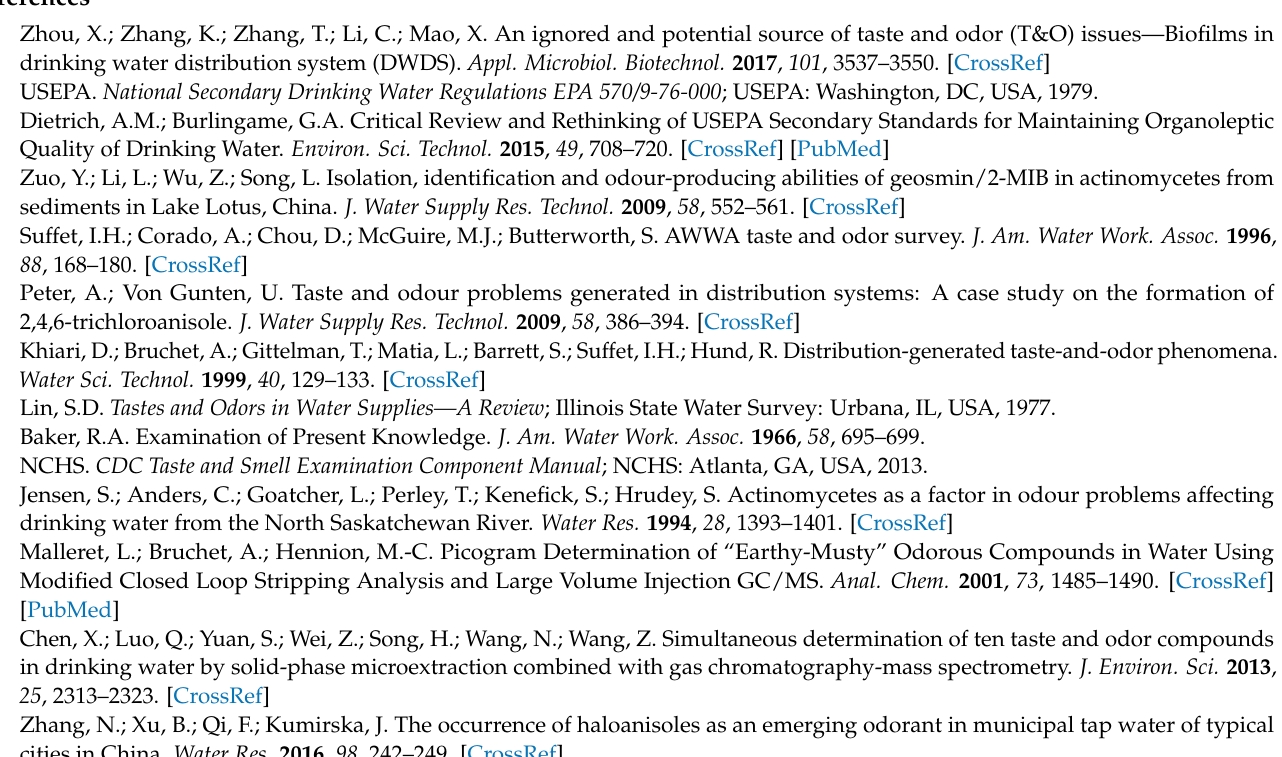
literature sources of the model parameters used, Table S2: Results of KLmod network simulations, Table S3: Average 2,4,6-TCA concentrations at the nodes and α 1 values for the Balerma network under T = 10 ◦